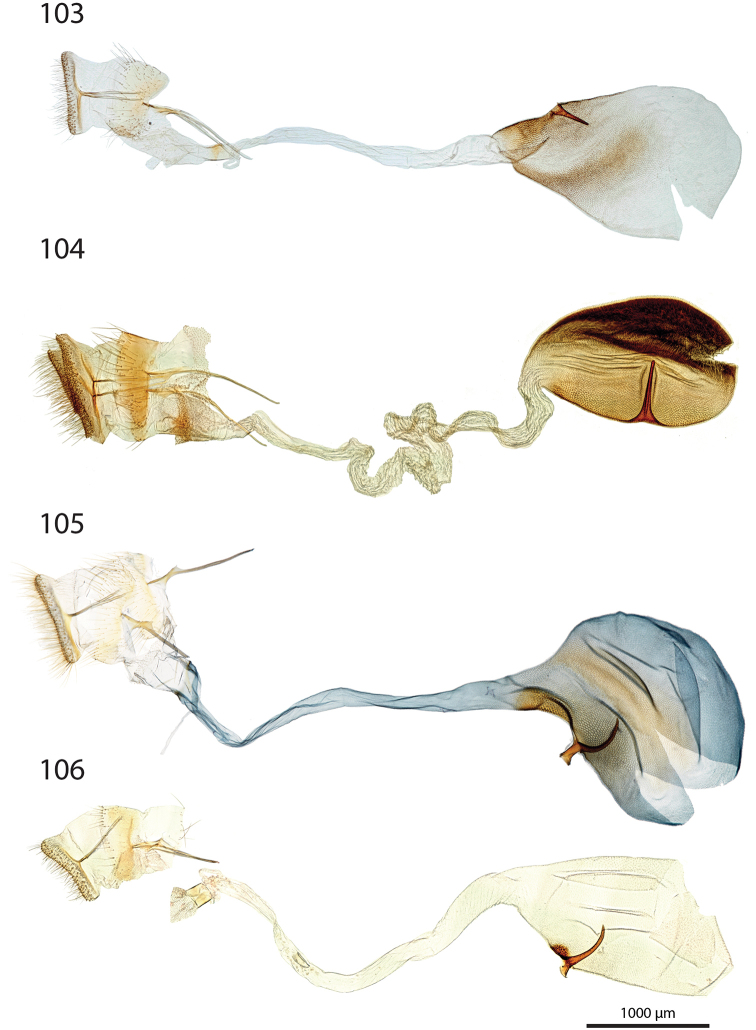
Female genitalia features of Hoploscopa. 103Hoploscopa
brunnealis, lectotype, Pyralidae Brit. Mus. Slide N° BMNH20247 ♀ 104Hoploscopa
ocellata, holotype, Pyralidae Brit. Mus. Slide N° BMNH20258 ♀ 105Hoploscopa
quadripuncta, TL713 ♀ 106Hoploscopa
semifascia, holotype, Pyralidae Brit. Mus. Slide N° BMNH20253 ♀.